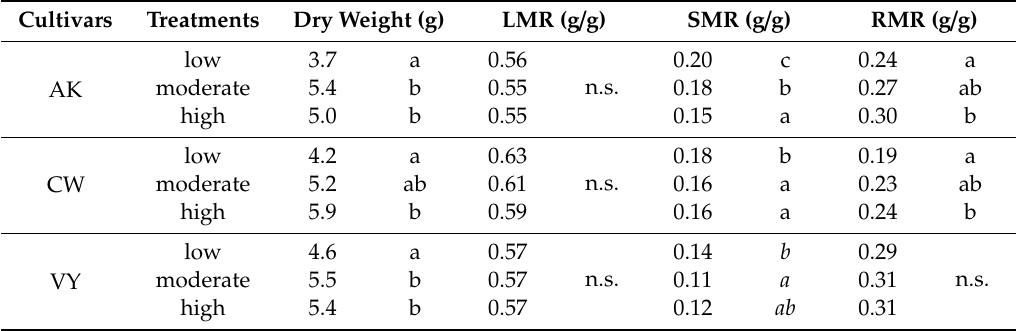
Table 1. Plant dry weight, leaf mass ratio (LMR), stem mass ratio (SMR), and root mass ratio (RMR) for each cultivar and treatment at the end of the